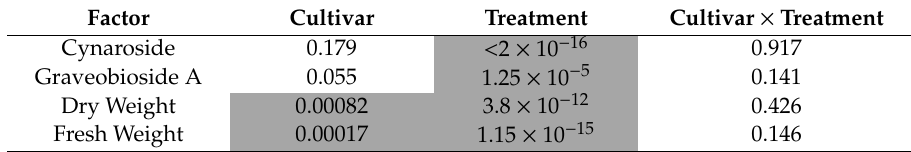
Table 1. Interaction and main e ff ect for treatments (control, salt-stress, combined-stress, UV-stress) and cultivars (Mavras and Stayer), calculated with a type I two-way ANOVA. Grayed area indicates significant e ff ect ( p ≤